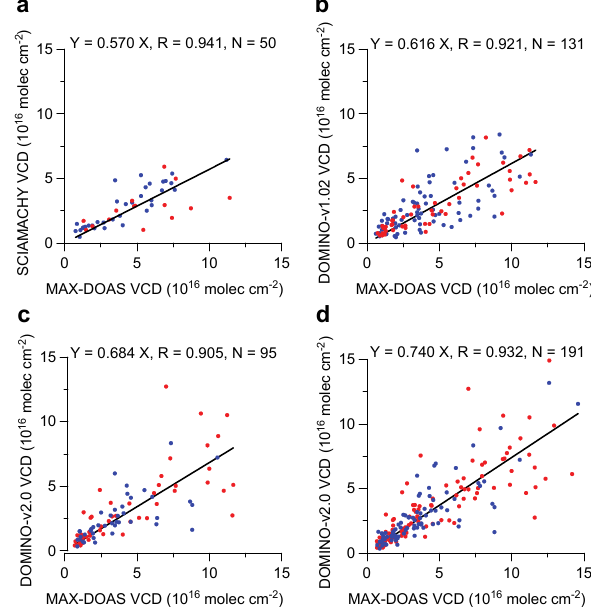
Fig. 14. Correlation of the hourly averaged tropospheric NO 2 VCDs over Beijing measured by ground-based MAX-DOAS with (a) co- incident SCIAMACHY satellite data (2008–2010), (b) coincident OMI satellite data (DOMINO v1.02, 2008–2009), (c) coincident OMI satellite data (DOMINO v2.0, 2008–2009), and (d) coinci- dent OMI satellite data (DOMINO v2.0, 2008–2011). Only data for days with CF < 0.3 are considered. Shown are regression results de- rived by combining the CTH < 1km (red points) and CTH > 1km (blue points) data together. The equation, Y = k · X , was used for regressions, with k for slopes, R for correlation coefficients, and N for sampling numbers. Results for separate correlation analyses for CTH < 1km and CHT > 1km are shown in Table 5.